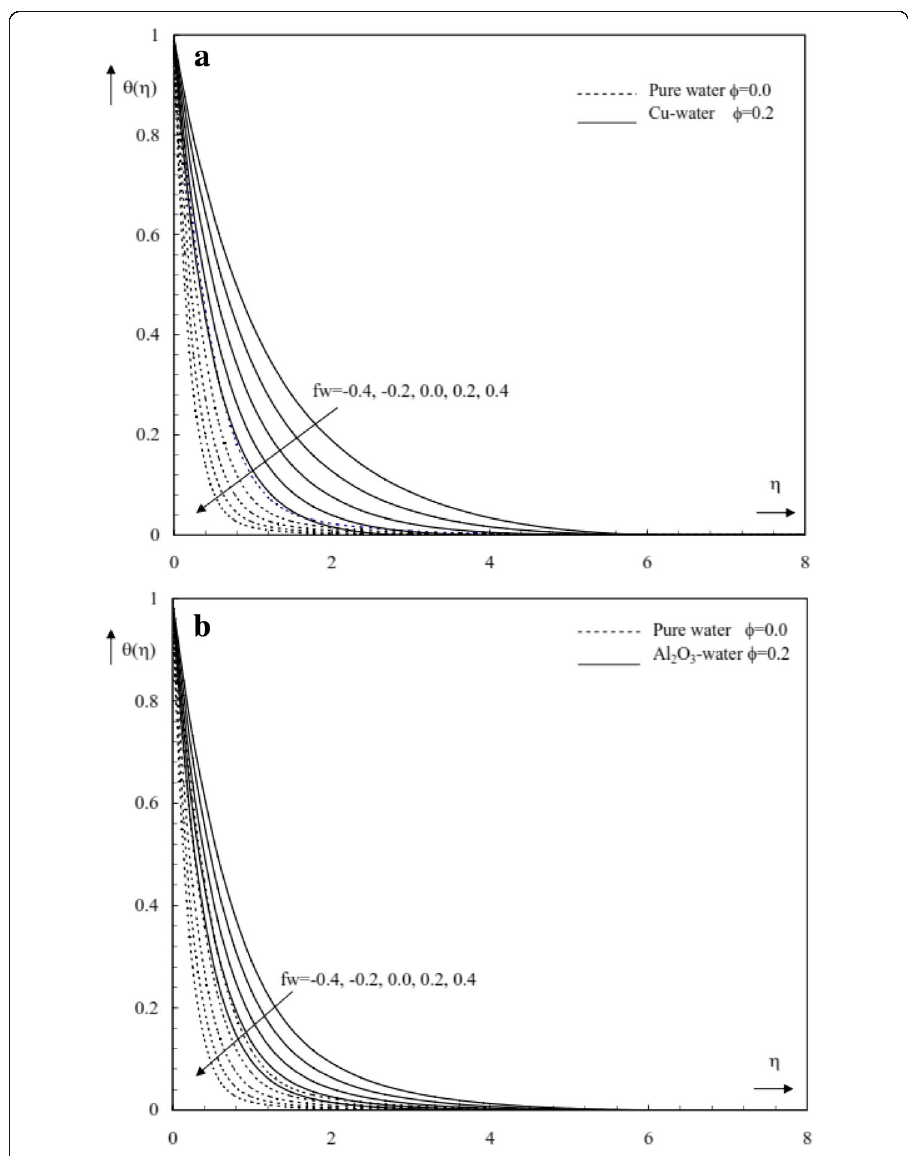
Fig. 8 Effects of ϕ and fw on temperature distribution θ ( η ) for S = M = 0.1 and A = B = λ = 0.5 for a Cu-water and b Al 2 O 3